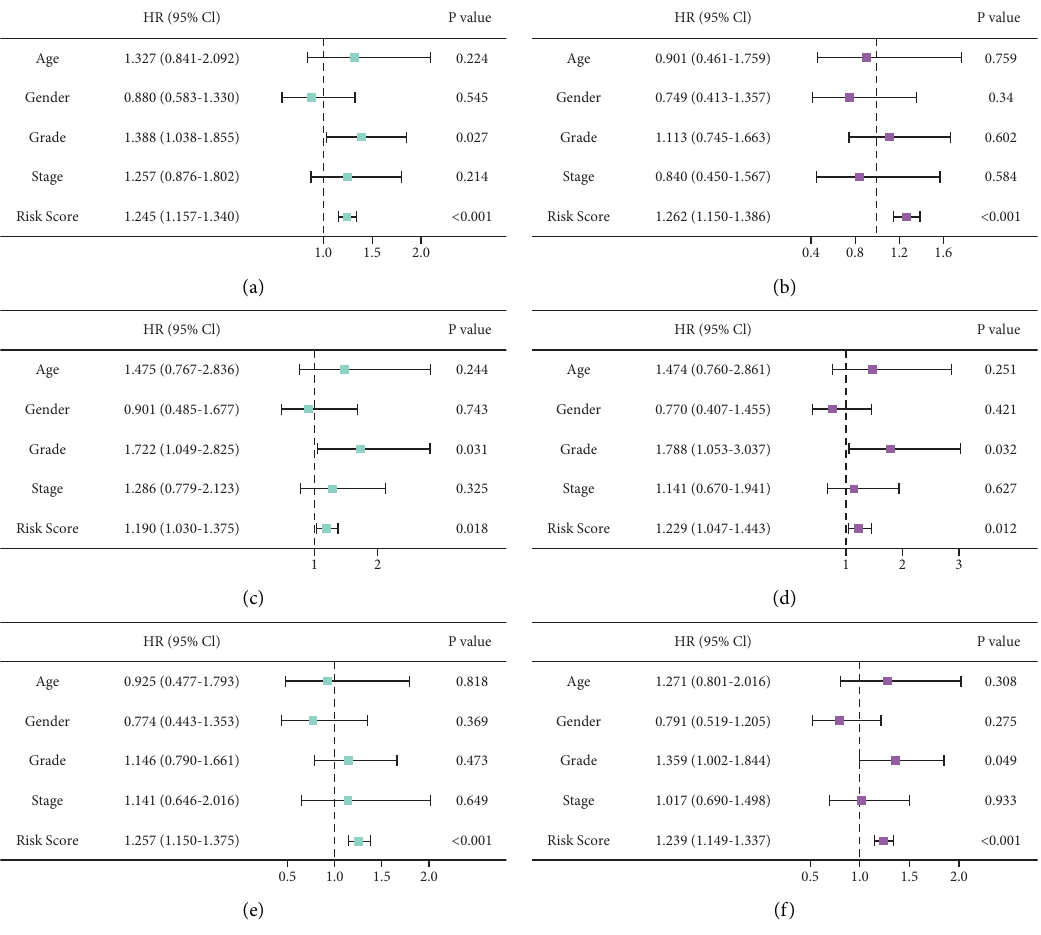
Figure 5: Independent prognostic analysis in the three groups. (a, b) Training set. (c, d) Validation set. (e, f) Entire